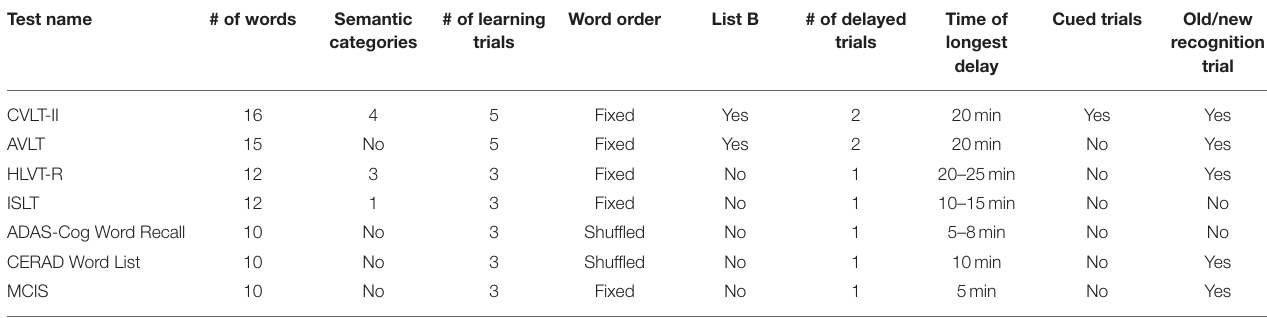
TABLE 1 | Commonly used wordlist memory tests and their